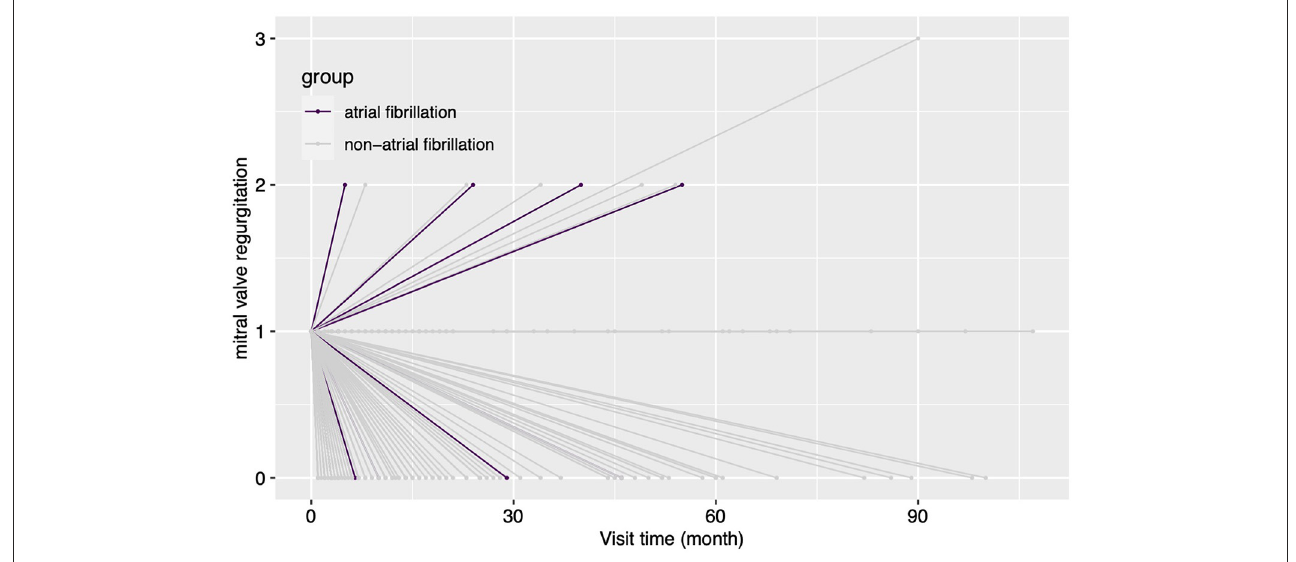
FIGURE4 The changes in the degree of MR for patients grouped by concomitant preoperative atrial fibrillation during the follow-up. In this figure, every line indicates the changes in the degree of mitral regurgitation for a single patient, and the two ends of a line indicate the preoperative echocardiography assessment and the last follow-up echocardiography assessment. MR, mitral